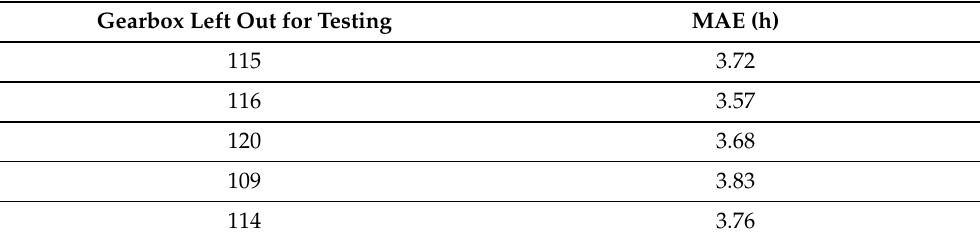
Table 3. Performance statistics of the TTF prediction strategy.